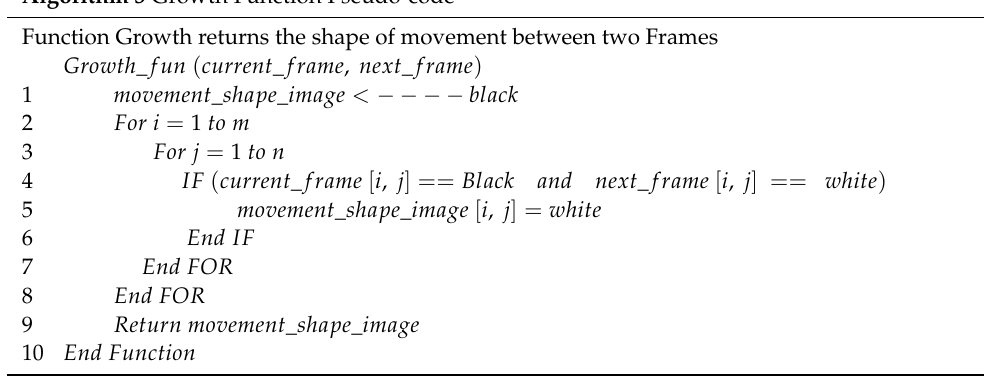
Algorithm 3 Growth Function Algorithm 3. Growth Function Pseudo-code.